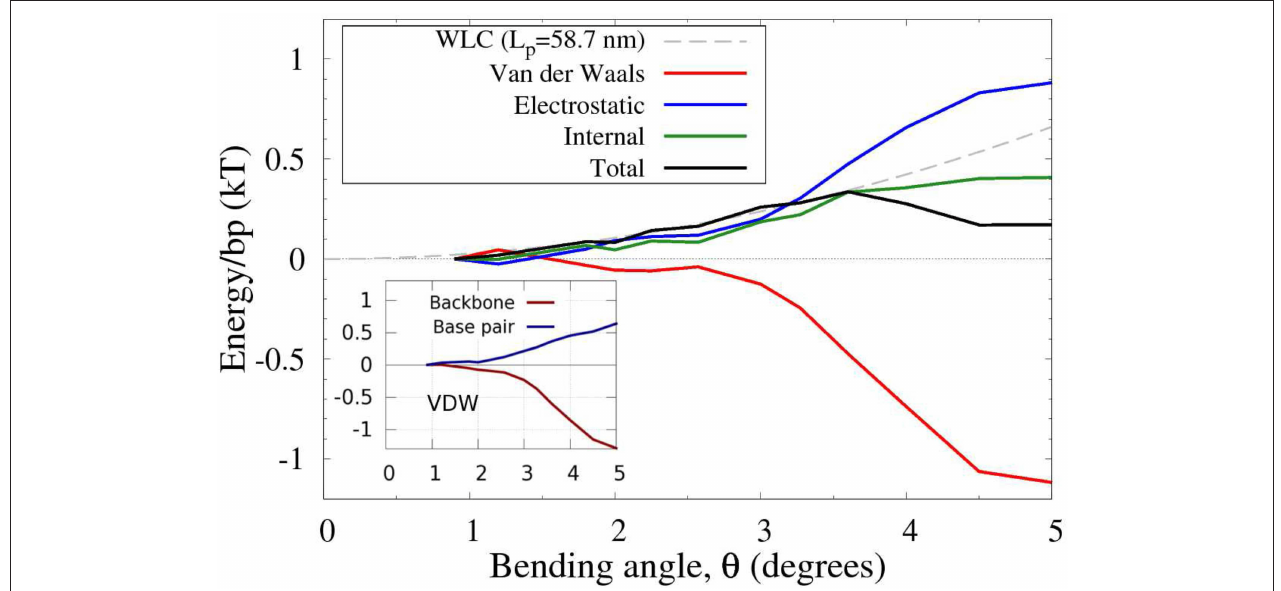
FIGURE 7 | Physical components of the (total) effective DNA bending energy from Figure 6 . The original range of bend angles is reduced for clarity. The energies are per base pair, inferred from all-atom MD simulations of uniformly bent DNA circles of variable lengths (50–400 bp). The main contribution to the non-convexity of the bending energy comes from the Van der Waals (VDW) interactions. The backbone-backbone part of these interactions contribute the most to the non-convexity due to a sharp increase in the attractive energy component for 3 ◦ < θ < 4 ◦ , as shown in the inset. For reference, a WLC fit for the small angle bends (up to ≈ 3.5 ◦ , gray dashed line) is